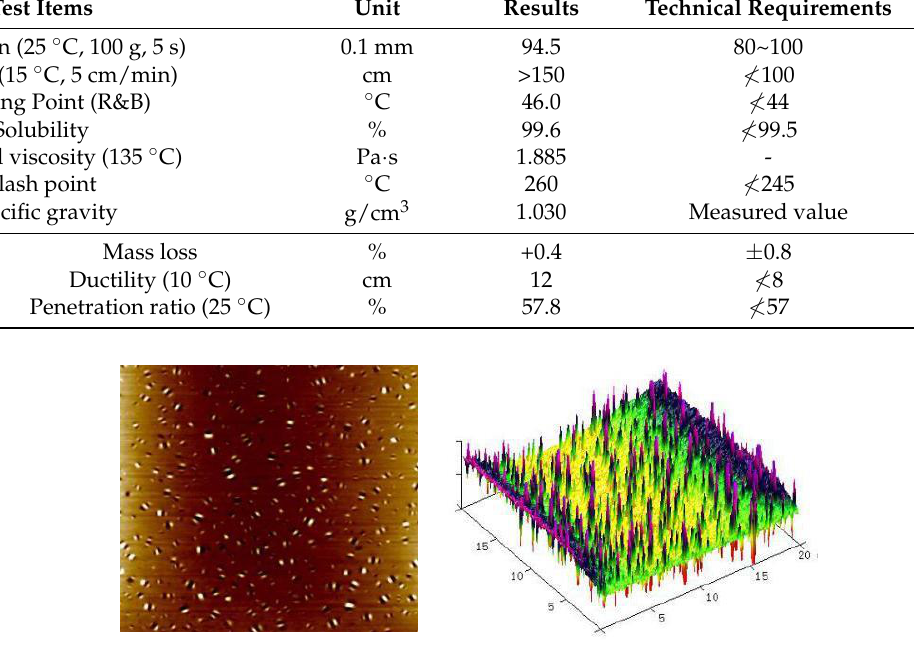
Figure 1. The atomic force microscope images of SK-90# matrix asphalt.